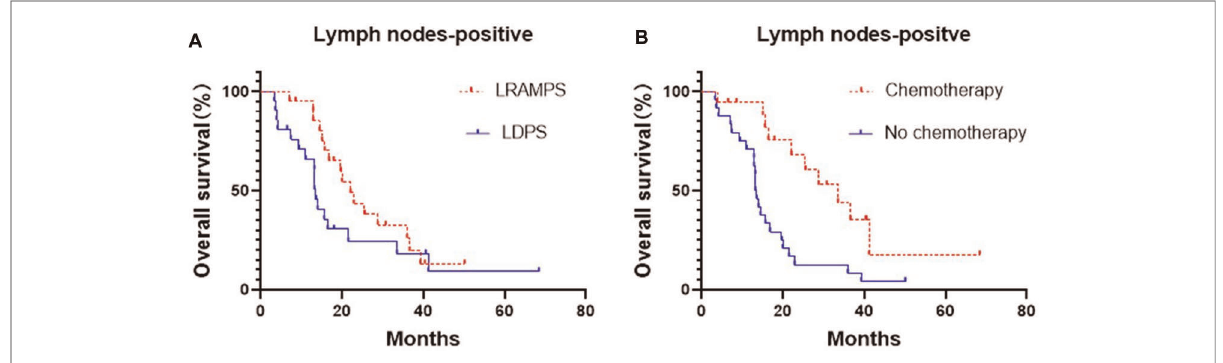
FIGURE 1 Median OS of positive lymph nodes patients, ( A ) LRAMPS: 22.1 months; LDPS: 13.57 months. ( B ) Chemotherapy: 33.5 months; no chemotherapy: 13.4 months.